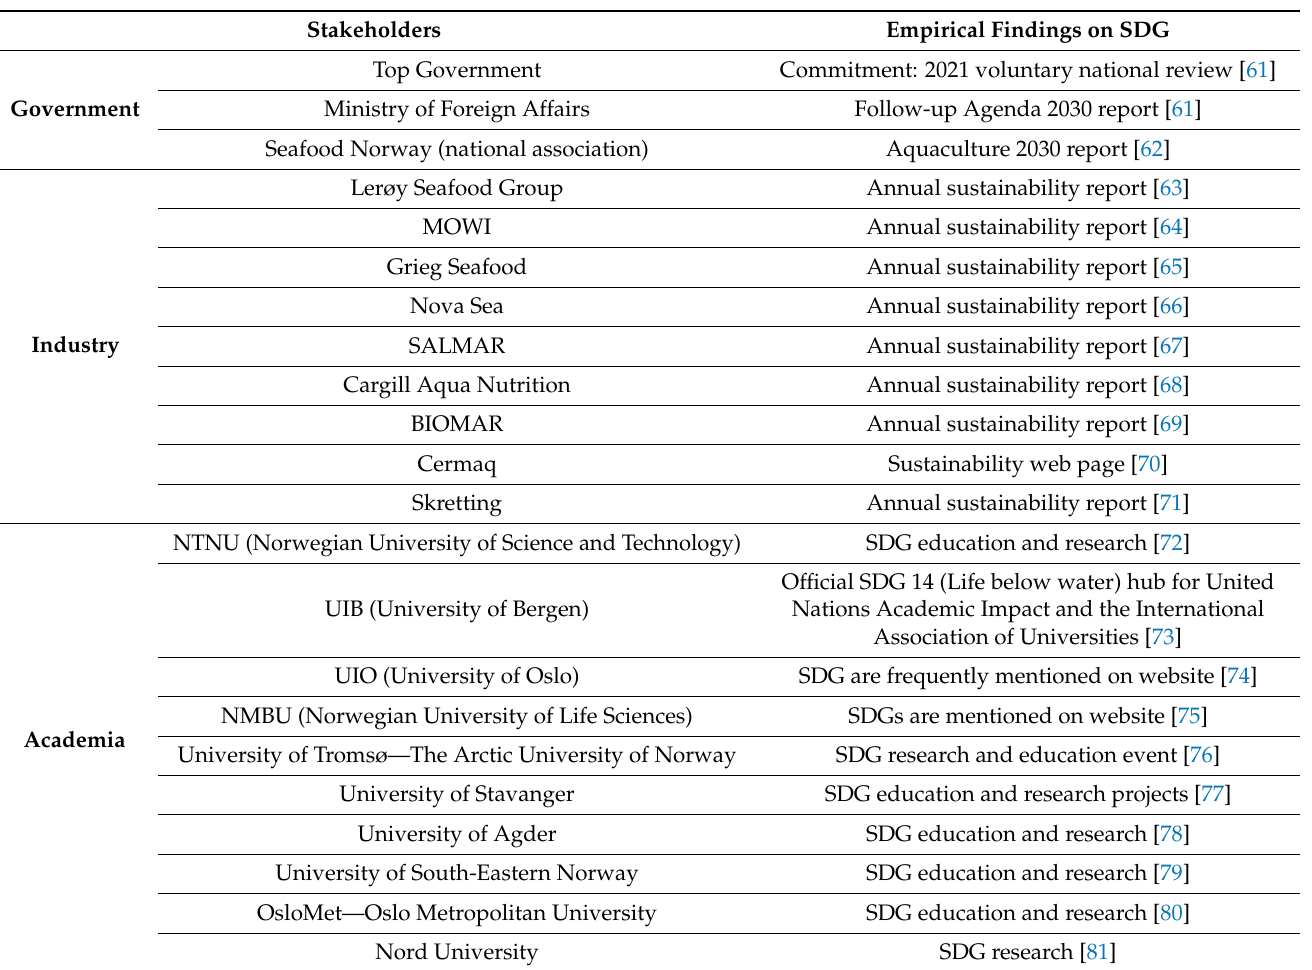
Table 4. Selected NSVC stakeholders for the scope of this